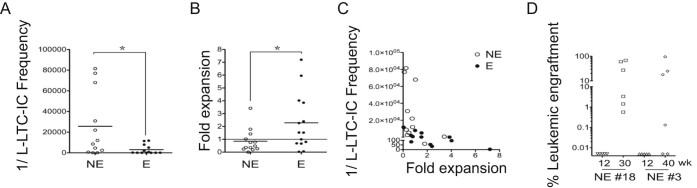
NE AML samples have a lower L-LTC-IC compartment size and a lower long-term expansion rate. (A) L-LTC-IC frequencies measured for 12 NE (open symbol) and 13 E (closed symbol). Data shown represent for each sample the initial cell number necessary for leukemic long-term culture maintenance (1/L-LTC-IC frequency). Plain lines represent mean levels in each group. (B) Data shown represent the fold expansion of 13 NE and 14 E samples after 5 weeks of co-culture on MS-5. Each symbol represents the mean result obtained from a single AML sample cultured in 5 to 20 wells. For (C) and (D), comparisons were made using a Mann–Whitney t test. *p < 0.05. (C) Fold expansion in function of the respective L-LTC-IC frequency. (D) Percentage engraftment in NSG mice of two NE: Nos. 18 and 3 at 12 and 30 and 12 and 40 weeks after injection, respectively. AML = acute myeloid leukemia; E = engrafter; L-LTC-IC = leukemic long-term culture-initiating cells; NE = nonengrafter.